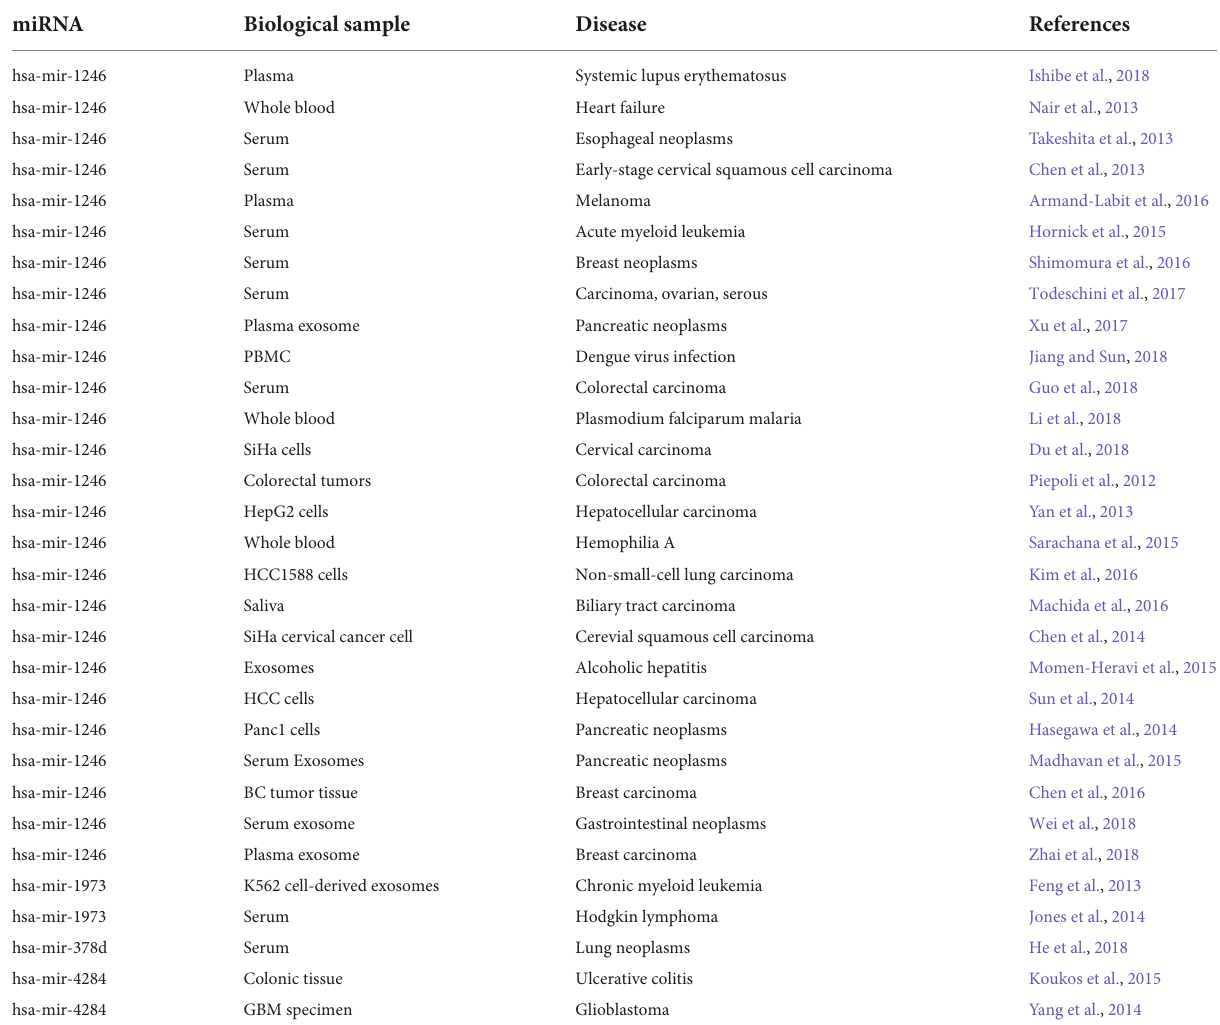
TABLE 9 Reports of disease association for the dysregulated miRNAs in current study.